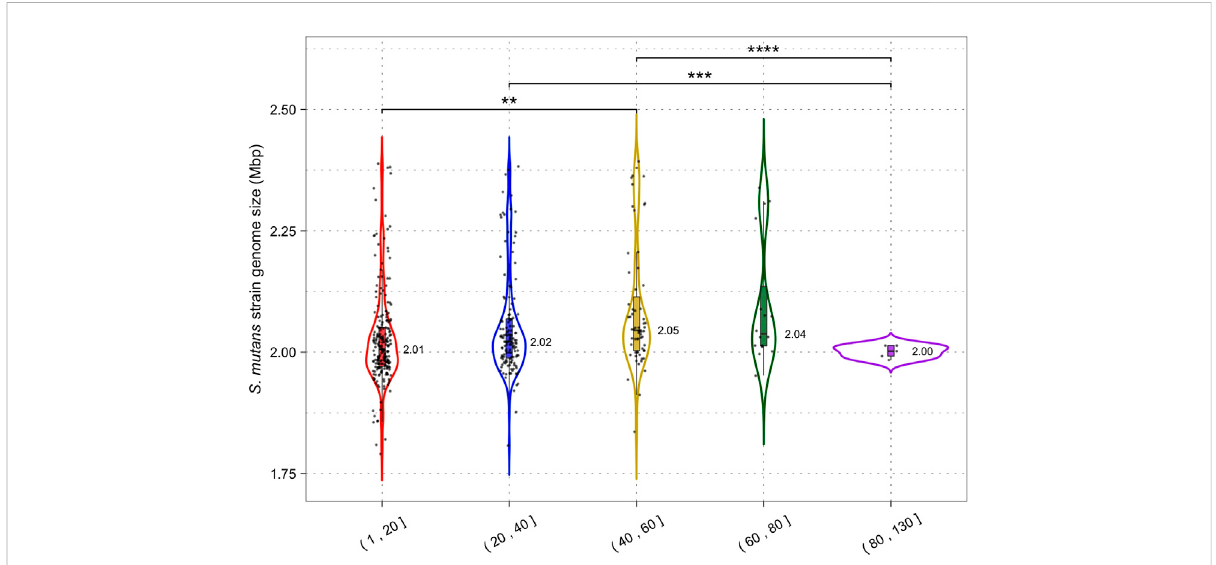
FIGURE 6 CRISPR activity and genome size. Genomes were grouped according to the number of CRISPR spacers present (1 – 20, 21 – 40, 41 – 60, 61 – 80 and 81+) and a violin plot was generated for each group. Median genome size (Mbp) is shown next to each violin plot; each dot is a single S. mutans strain/genome. Statistical signi fi cance between groups was calculated using a two-tailed t -test (** = p < 0.01; *** = p < 0.001).